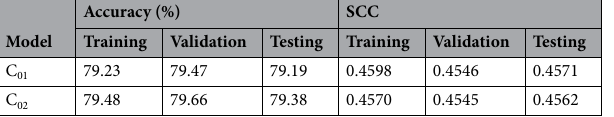
Table 5. Accuracy and SCC values attained for the C 01 and C 02